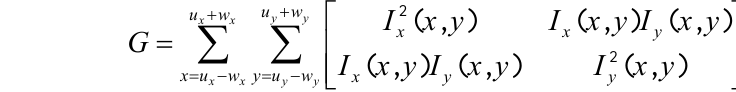
C at time 1-t . (b) The  t 1 B . (f) The accurate t